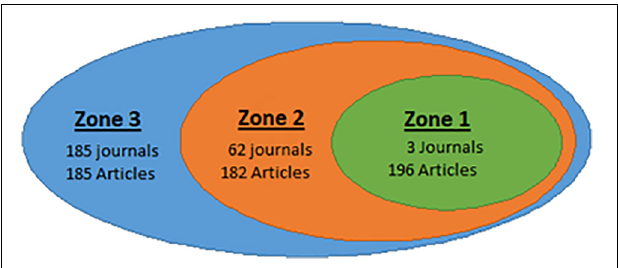
FIGURE 2 | Scatter diagram of journals and articles on art therapy retrieved through the core WoS collection. Total number of journals: 250, total number of articles: 563.